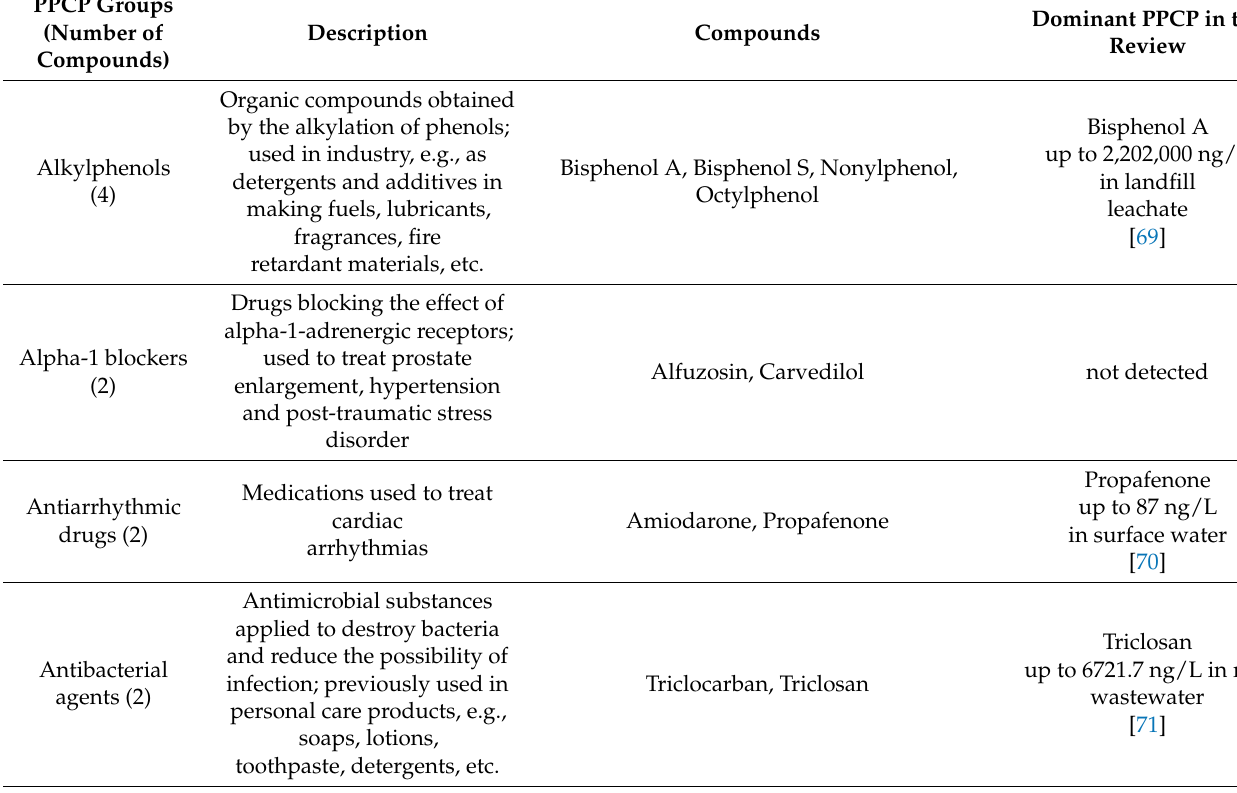
Table 1. The list of PPCP groups analysed in the water environment of